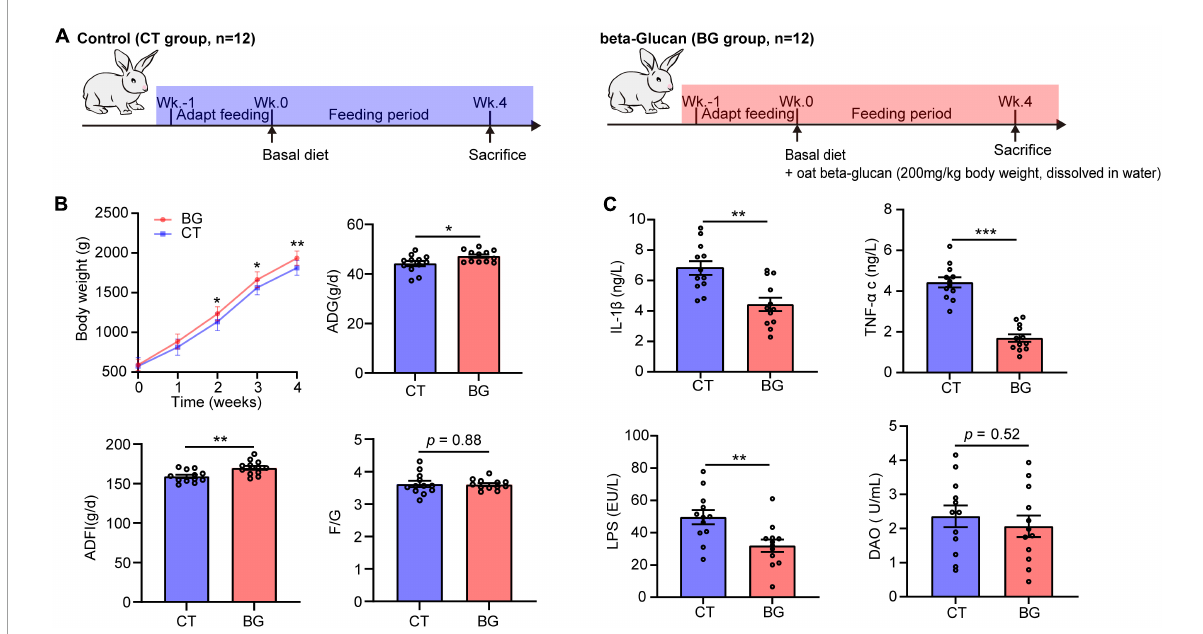
FIGURE1 (A) Experimental setup for control (CT) and oat β -glucan (BG) groups. (B) Oat β -glucan improved growth performance. ADG, average daily gain; ADFI, average daily food intake; F/G, feed-to-gain ratio. Body weight (BW) data are presented as means ± SD. (C) Oat β -glucan decreases serum TNF- α , IL-1 β , LPS, and DAO contents. TNF- α , tumor necrosis factor- α ; IL-1 β , interleukin-1 β ; LPS, lipopolysaccharide; DAO, diamine oxidase. * p < 0.05, ** p < 0.01, and *** p <